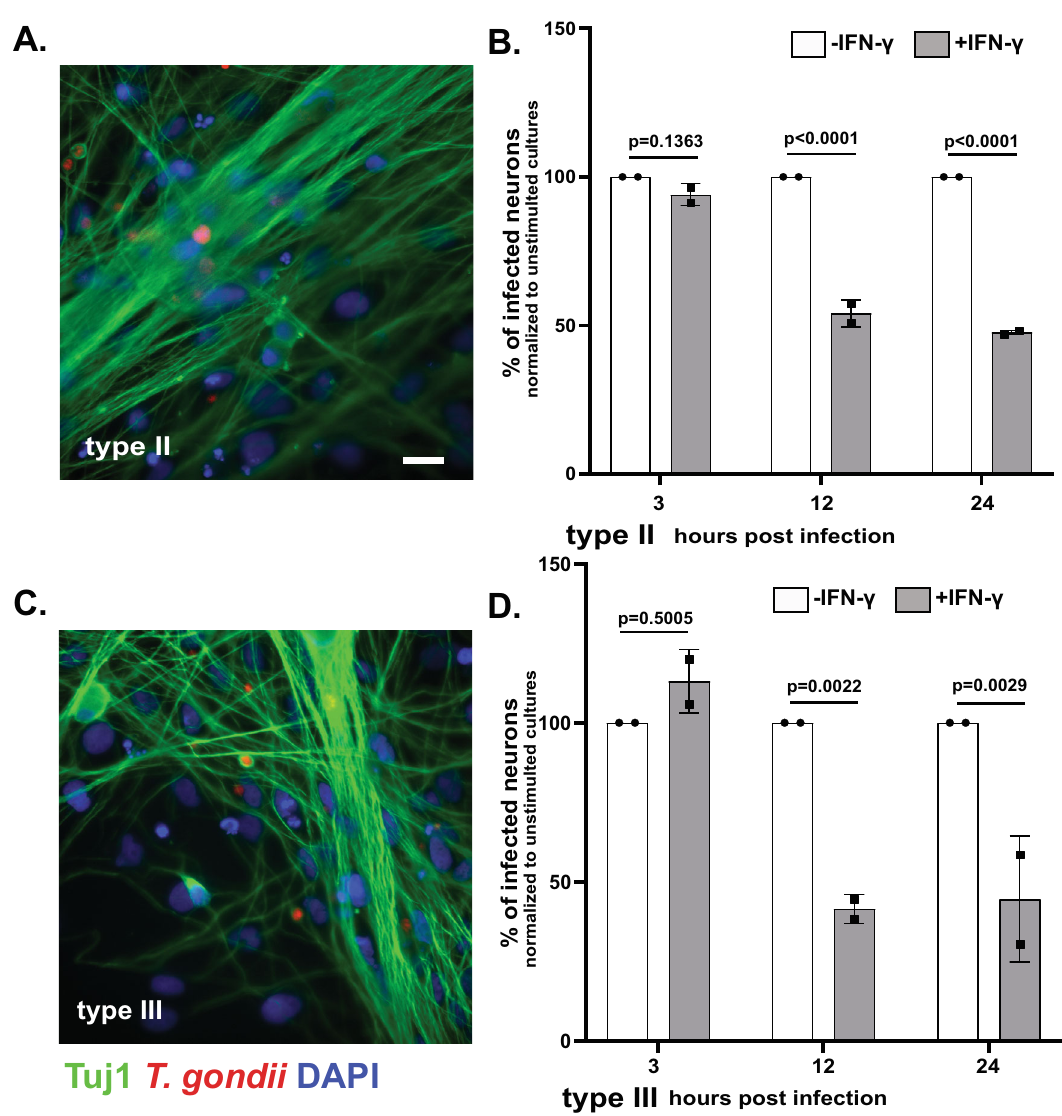
Fig. 6 | IFN- γ stimulation of human neurons leads to a decrease in the per- centage infected with T. gondii . Human neurons cultures were stimulated with human IFN- γ (100 U/ml) or vehicle for 24h, followed by infection with listed T. gondii strains. At listed time points, cultures were fi xed, stained with anti-Tuj1 antibodies and DAPI, and analyzed on an Operetta ® CLS ™ high content analysis microscope. A Representative images of human neurons infected with type II